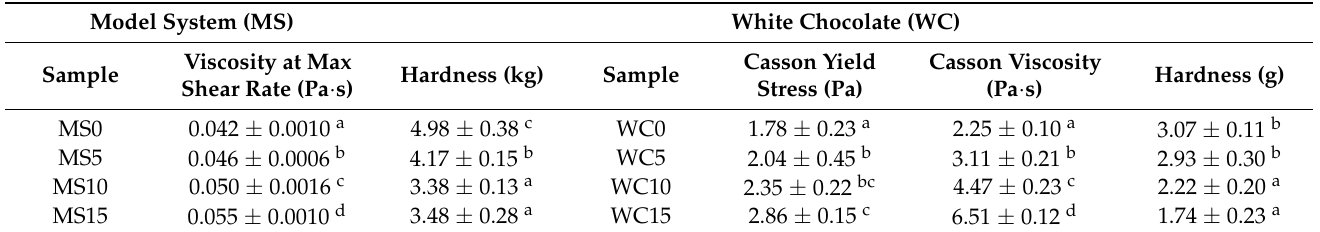
Table 1. Rheological parameters and hardness of model system and chocolate.